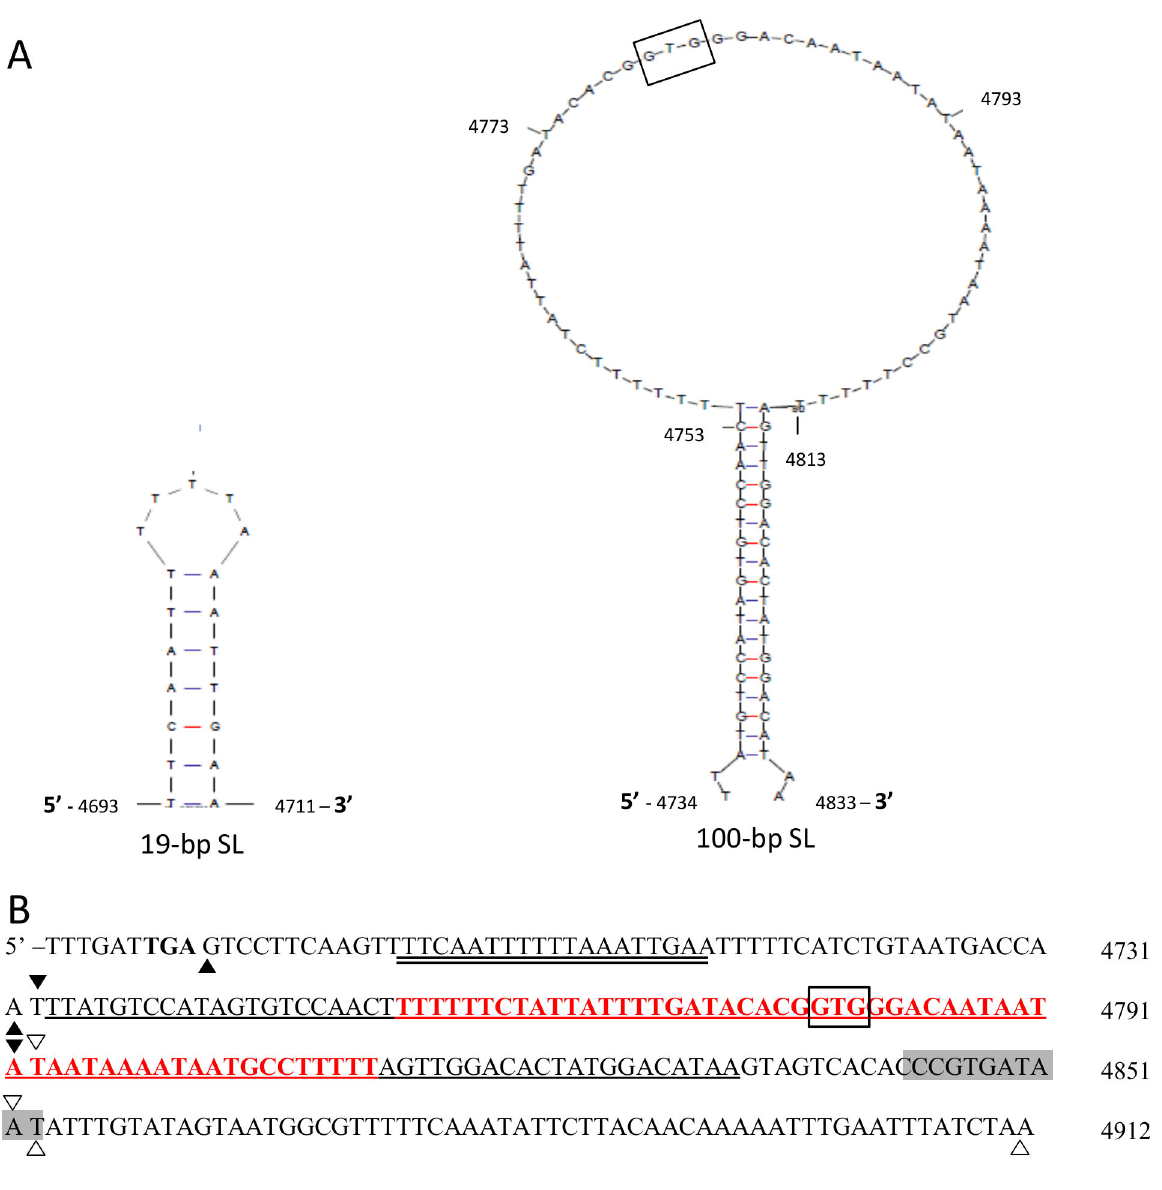
Figure 4. Stem-loop structures identified within the 232-bp pRN1 putative origin of replication. (A) The secondary structure of 232-bp putative origin of replication determined using DNA mFold, revealed the presence of 100-bp (4734 - 4833) and 19-bp (4693 - 4711) stem-loop (SL) structures at 70°C. (B) DNA sequence of the 232-bp putative origin of replication showing the 100-bp SL (single underline) and 19-bp SL (double underline) in pRN1 origin. Deletions made in pRSP1a (between ∆), pRSP1b (between ∇ ), pRSP1c (between ▼) and pRSP1d (between ▲) are highlighted by the triangles, while the deletion in pRSP1e is shaded. The ‘GTG’ motif (box) and the loop of the 100-bp SL (red) are also highlighted.